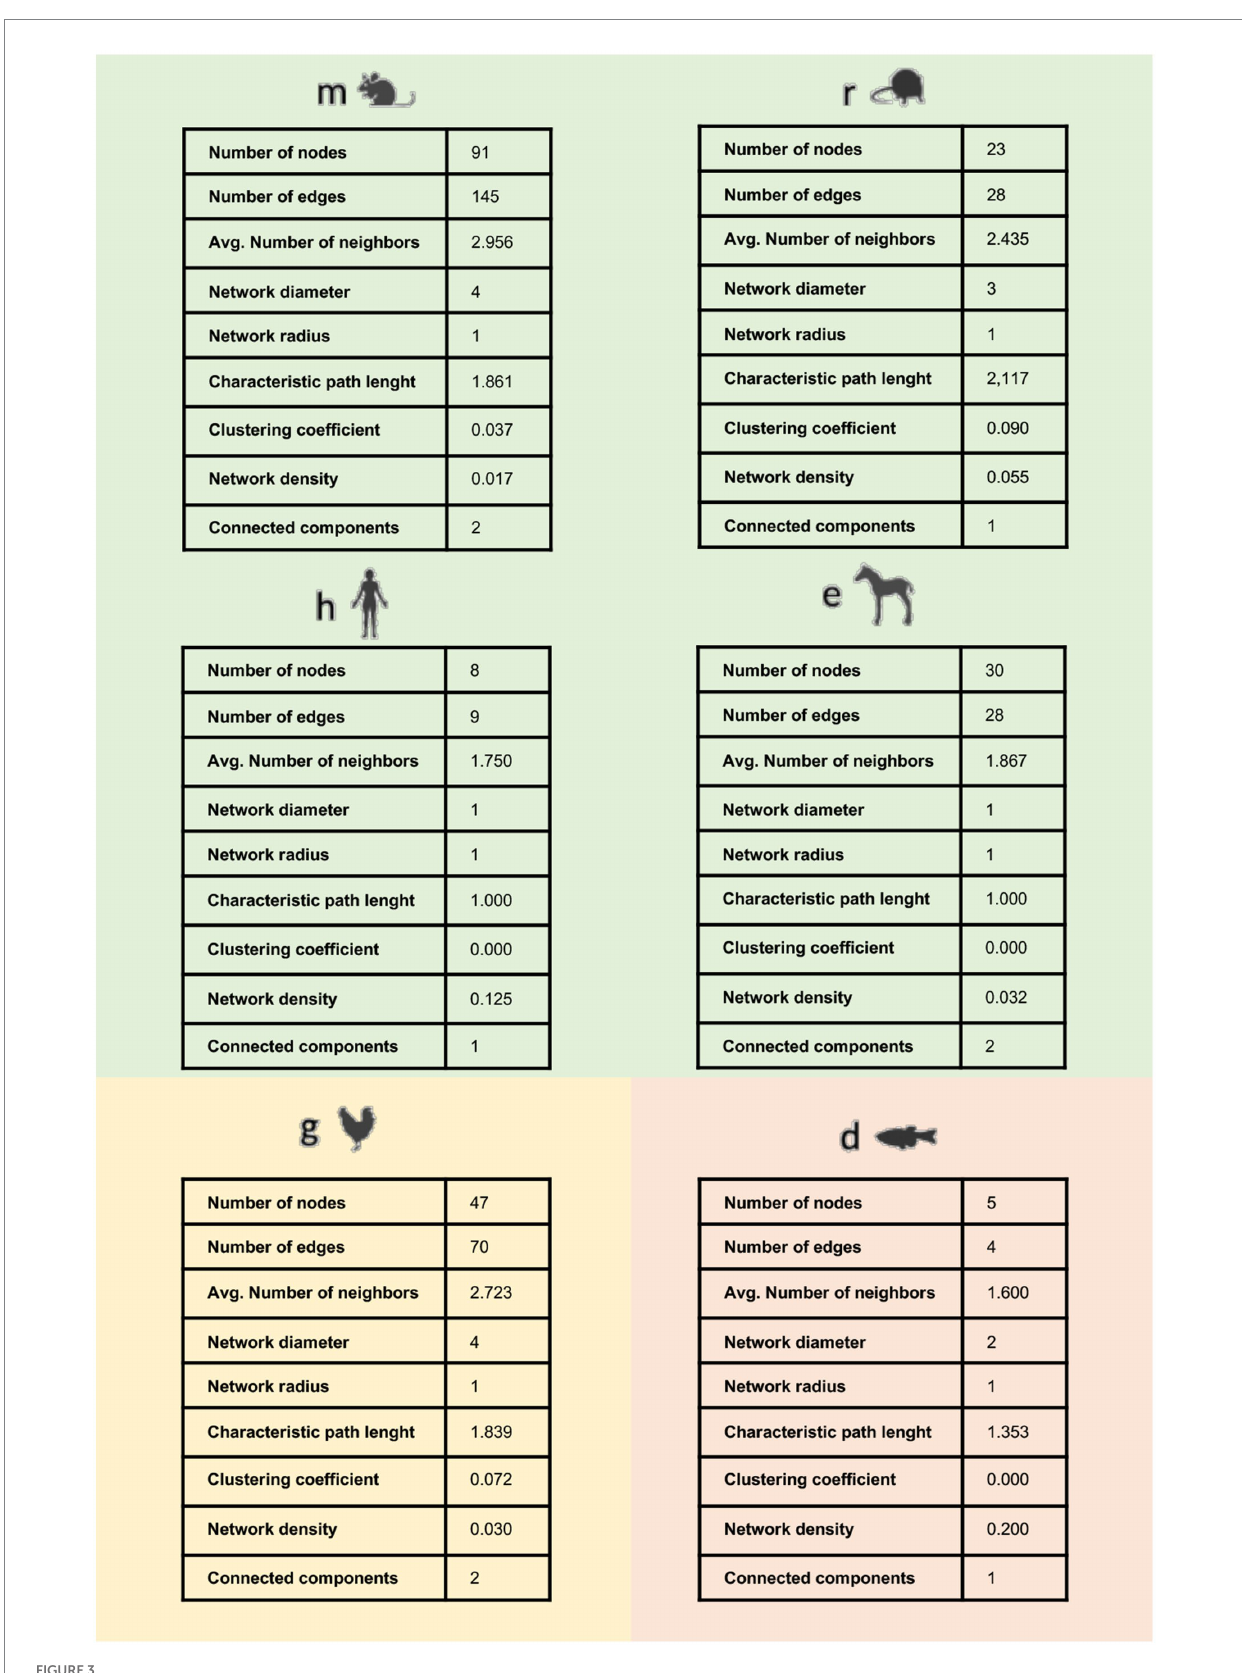
FIGURE 3 Main topological parameters of species-specific TendonNETs. Topological analysis was not accomplishable for the Bos taurus dataset based on the limited number of retrieved